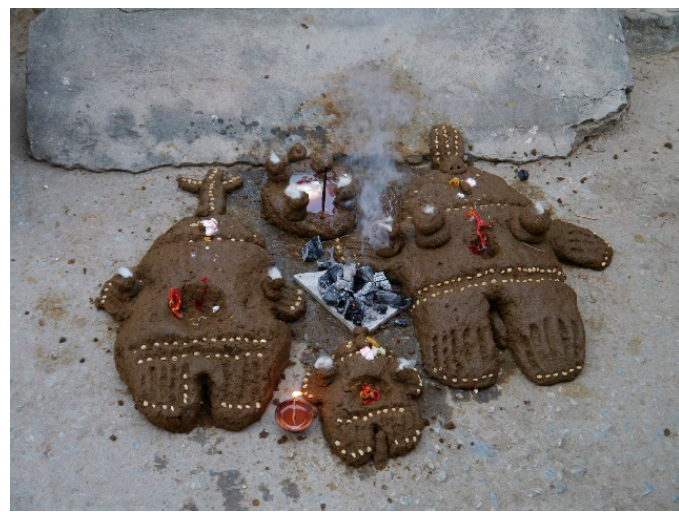
Figure 15. Govardhan representing a human family, Havala 2017 (picture by Author).